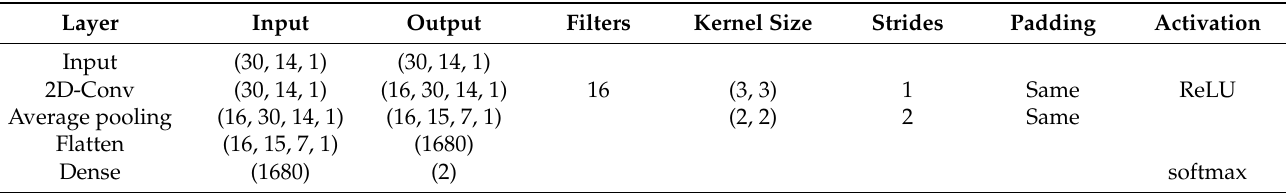
Table 3. The parameters of the fault diagnosis model.